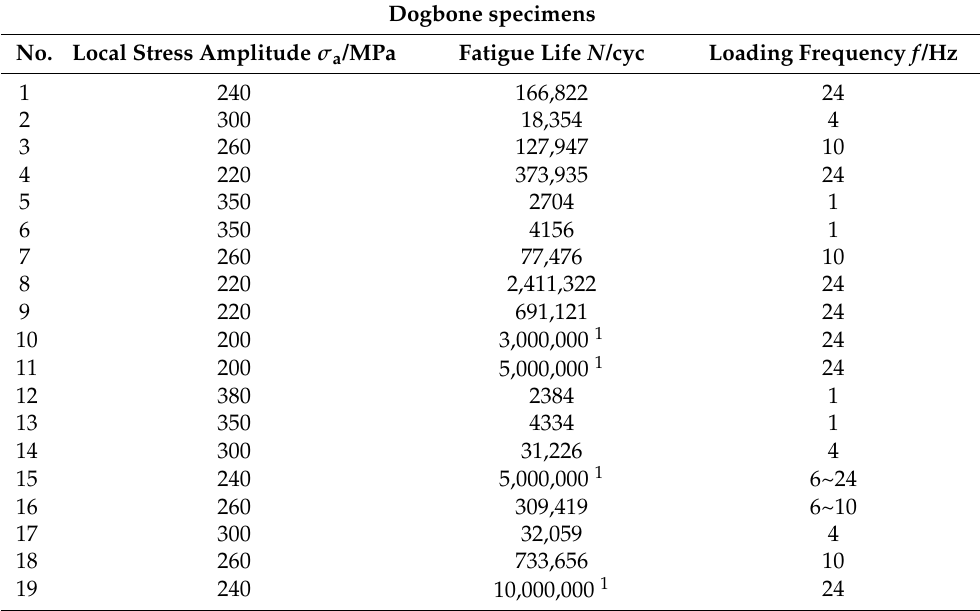
Figure 5. SEM images of the fracture surface for the hourglass specimen with multi-site crack initi- ation, local stress amplitude σ a = 315 MPa, N = 7.96 × 10 4 . ( a ): Fracture surface with low magnification; ( b – d ): close-ups of crack initiation regions A, B, and C in ( a ). SEM images of the fracture surface of several dogbone specimens are shown in Fig- ures 6 and 7. Similar to hourglass specimens, the fatigue cracks initiate from the specimen